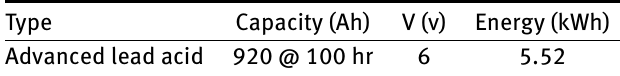
Table A12: Battery data and characteristics.